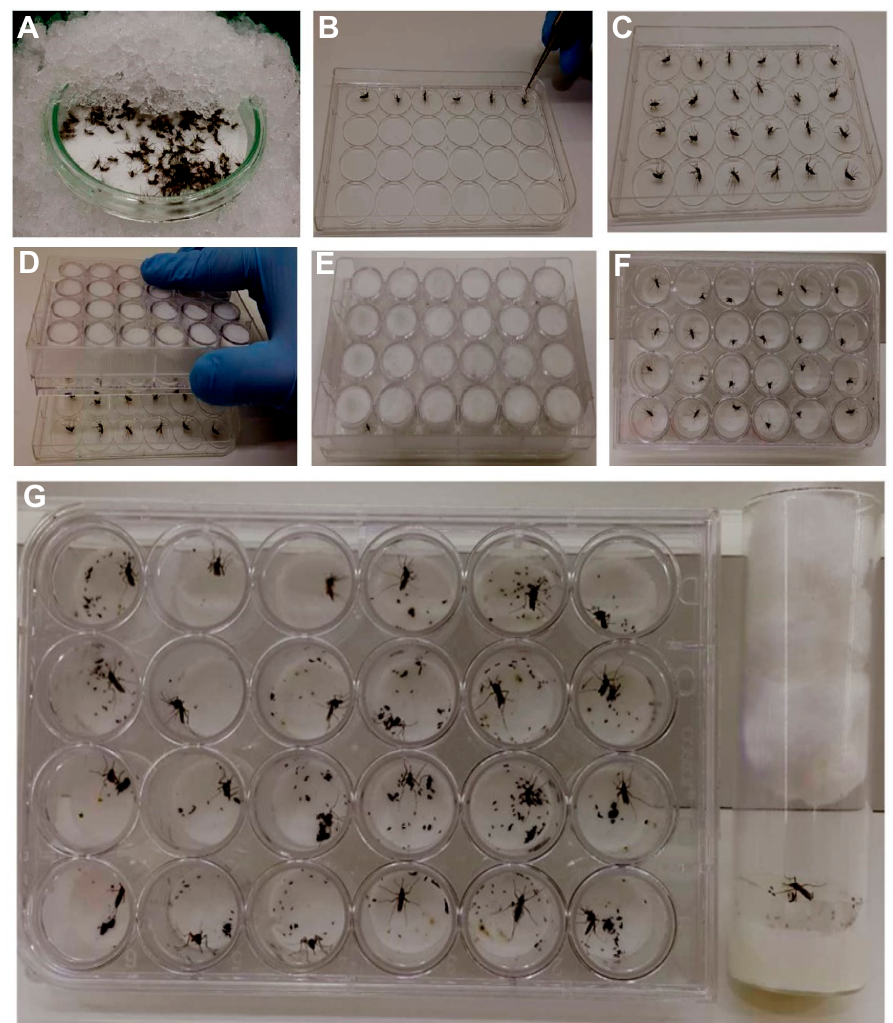
Figure 3. The steps to assemble the oviposition assay using the 24-well plate. ( A ) Put the anesthetized vitellogenic females on a glass petri dish over crushed ice for 15 min. ( B ) Place the females in the middle of the circle mark of the plate cover lid using forceps. ( C ) Completed lid with female mosquitoes. ( D ) Positioning the mounted plate upside down to cover the lid containing the ice-anesthetized mosquitoes. ( E ) Wait the mosquitoes to recover. ( F ) Invert the plate to the right position. ( G ) Keep the oviplate inside the insectary.